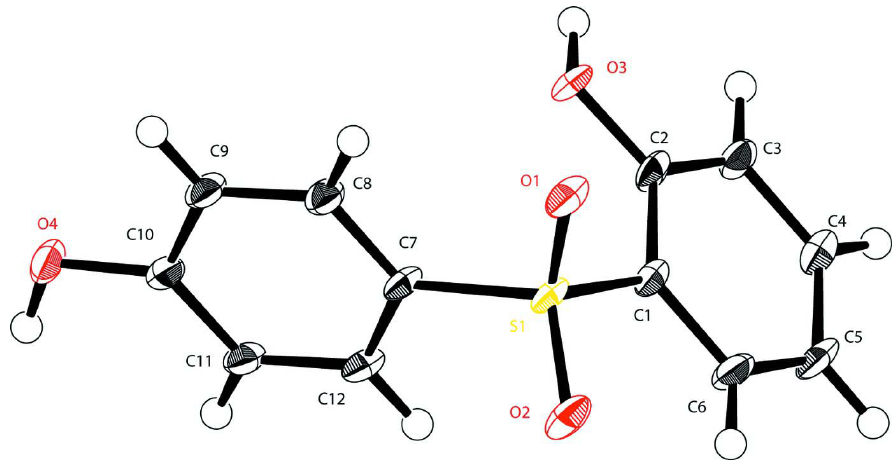
Figure 1 A view of the molecular structure of (I), showing 50% probability displacement ellipsoids for non-H atoms.